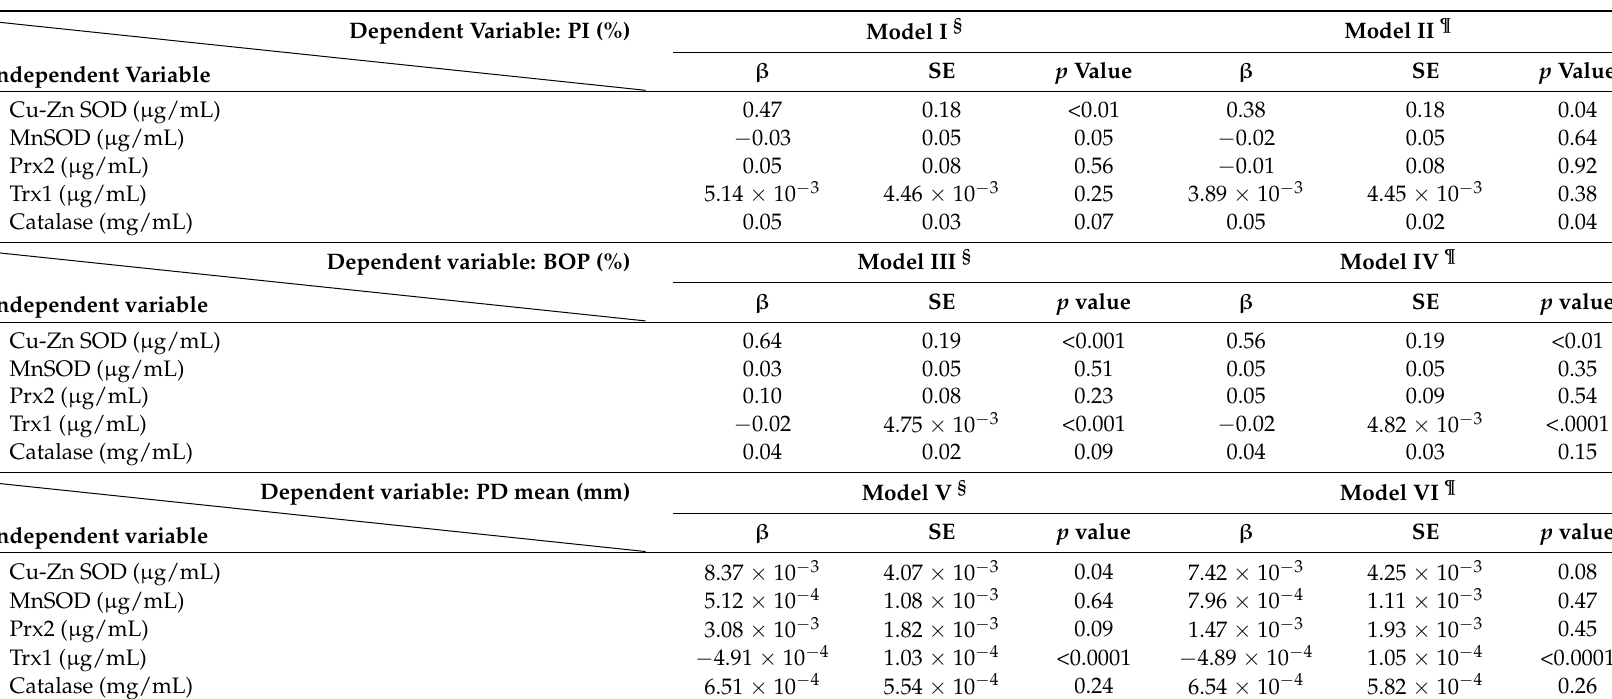
Table 4. Multiple regression analysis of salivary oxidative stress biomarkers and clinical periodontal parameters in subjects whose last previous dental visit was >1 year ( N =